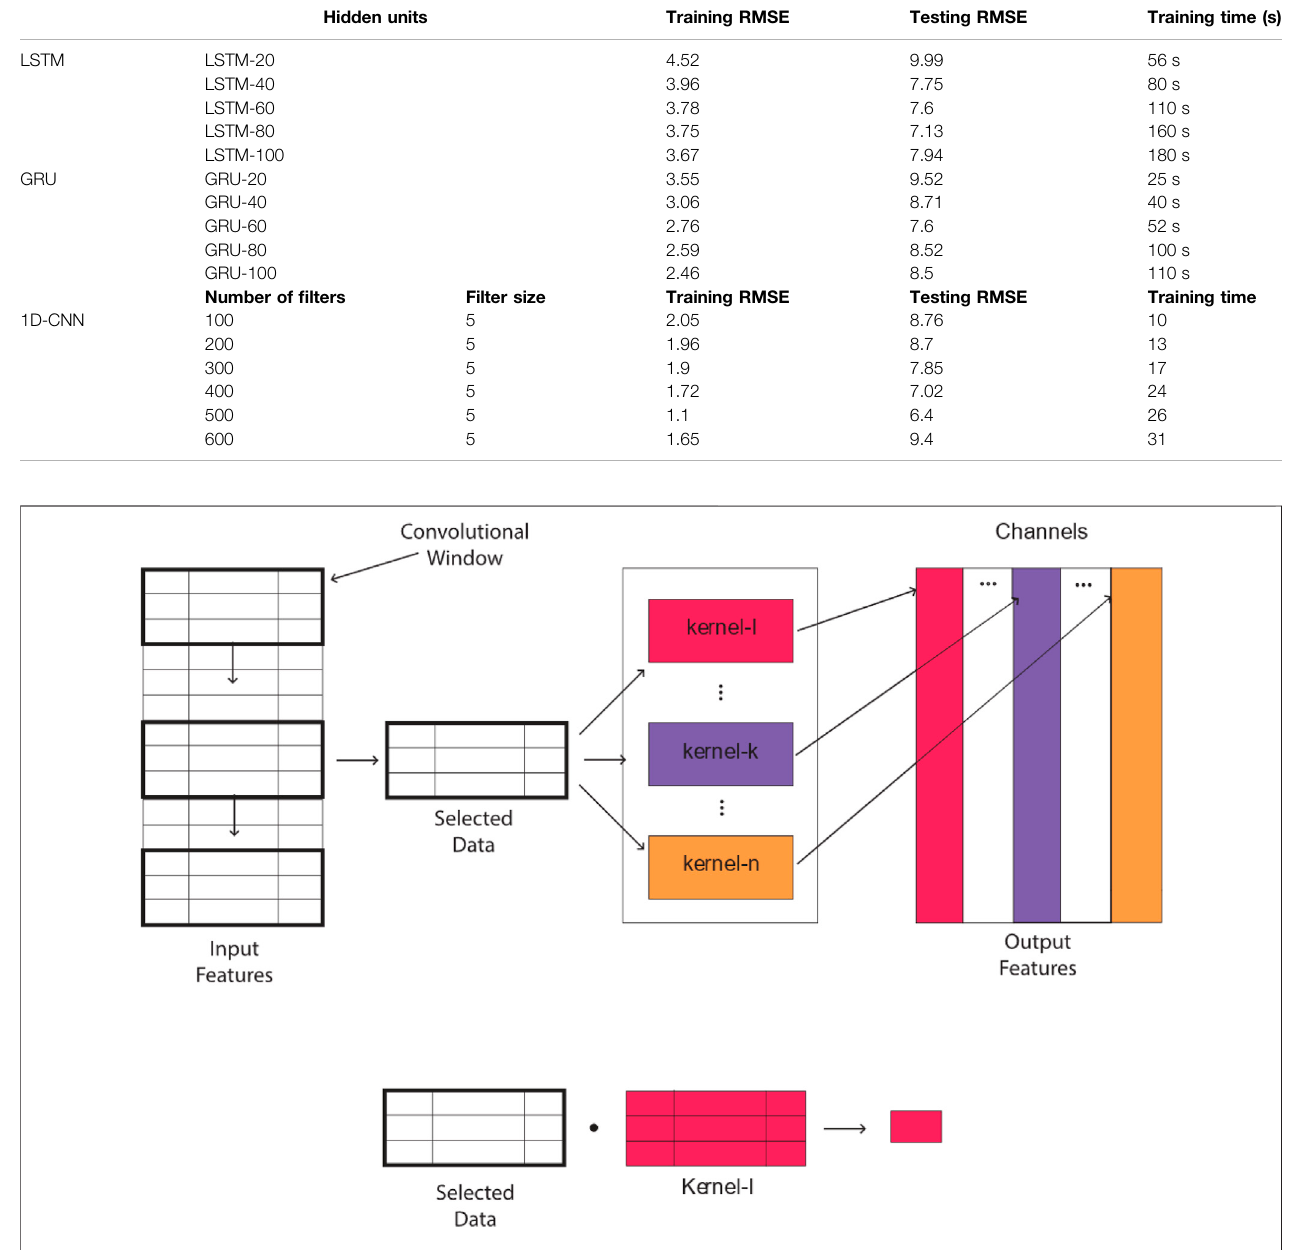
TABLE 3 | Performance metrics results of LSTM, GRU, and 1D-CNN with varying hyperparameters. Models